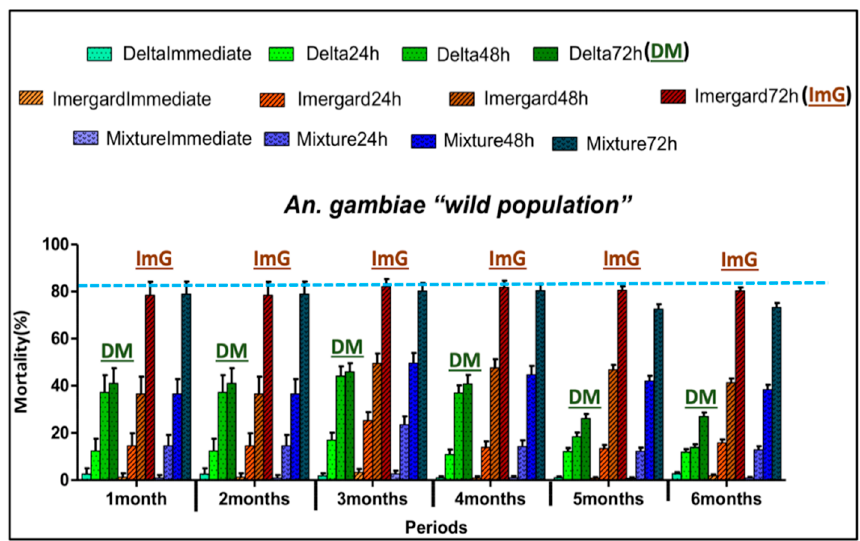
Figure 3. Monthly mortality rates of free-flying resistant Anopheles gambiae (s.l.) entering experimental huts in Cove, Benin. For each treatment, mortality was recorded at collection time (immediate) and then at 24, 48, and 72 h after collection. Error bars represent 95% confidence intervals. Delta and DM = Deltamethrin; ImG = Imergard TM WP; Mixture = Deltamethrin + Imergard TM WP. The blue dotted line indicates highest mortality rates obtained in mosquitoes collected in the huts.